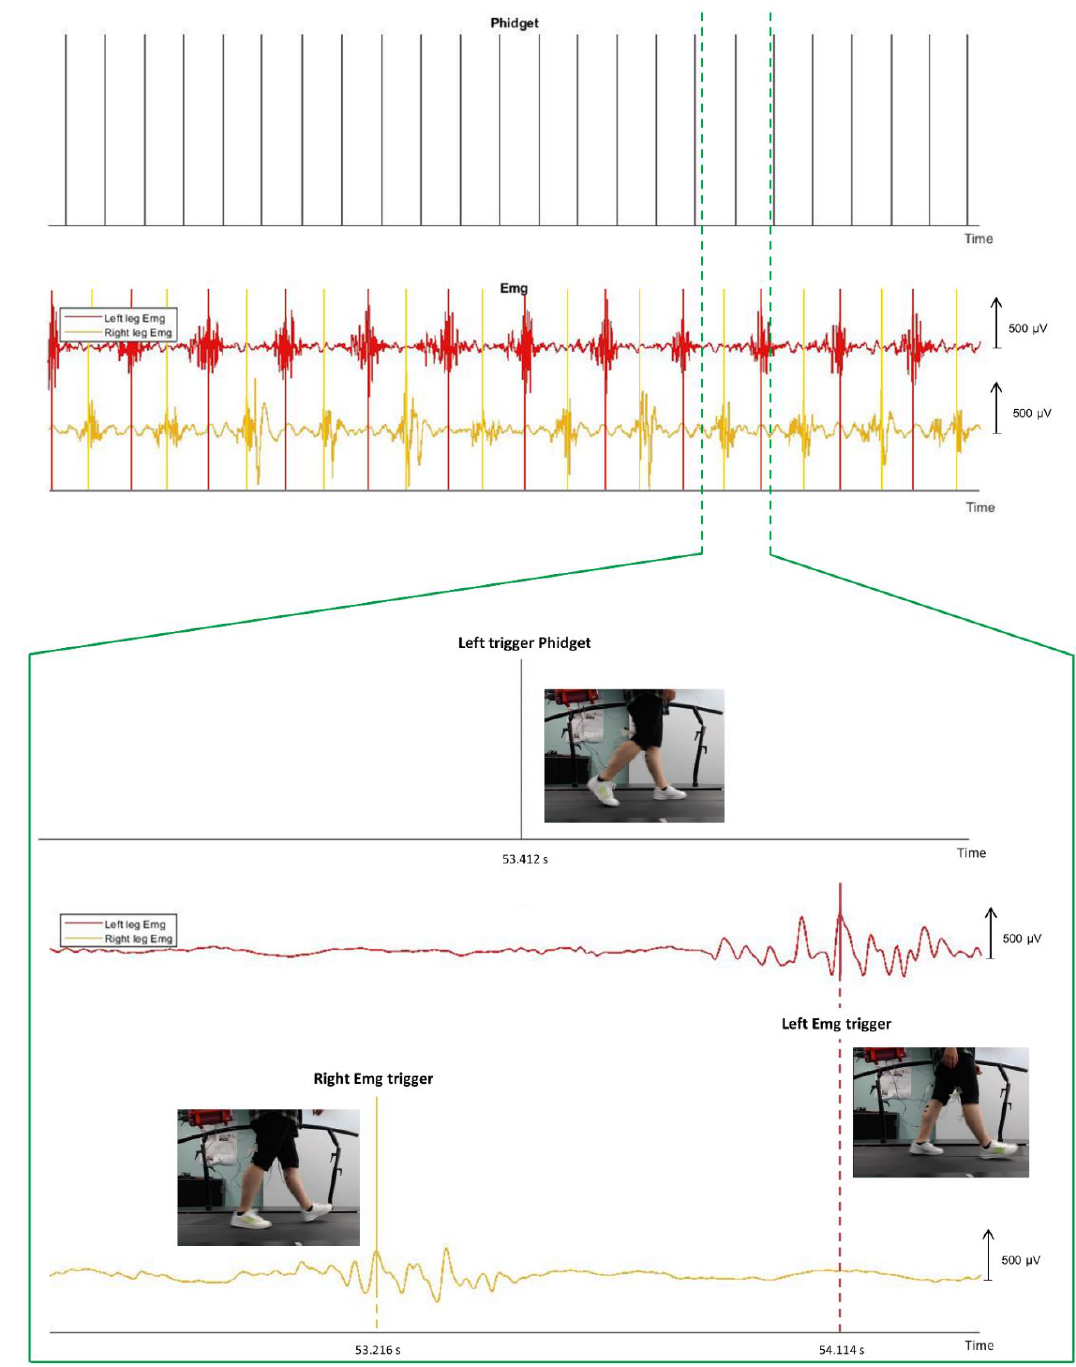
Figure 3. Upper panel: example of synchronized Phidget and EMG signals. Bottom panel: detail extracted from the upper panel relative to a left step identification. Specifically, the Phidget trigger detecting a left leg IC is shown with the corresponding trigger extracted from the EMG signal (vertical red line) and the video frame corresponding to both Phidget and EMG triggers. The contralateral EMG signal is also shown along with the video frame corresponding with the identification of the right leg EMG trigger (vertical yellow line). It is clear that the Phidget trigger occurred during the foot strike and preceded the ipsilateral EMG peaks, which occurred in the pre-swing phase.